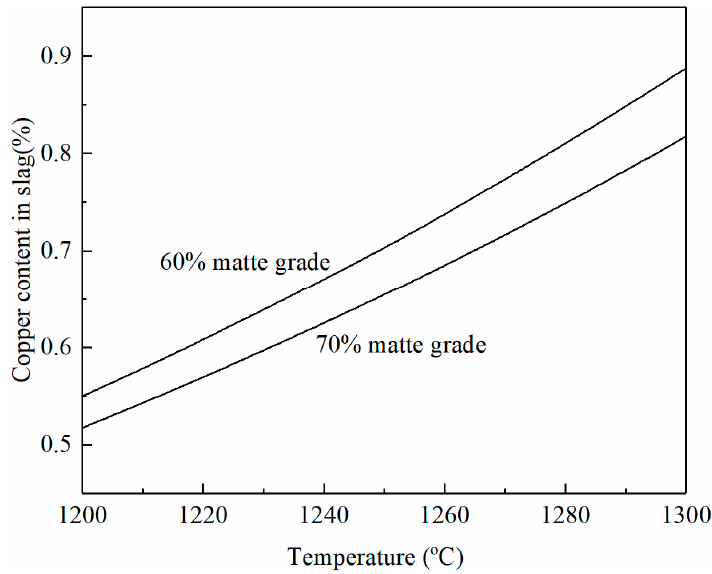
Figure 5. Effects of temperature and matte grade on copper content in smelting slag at a fixed SO 2 partial pressure of 0.3 atm and a Fe/SiO 2 ratio of 1.3, predicted by FactSage 8.2.